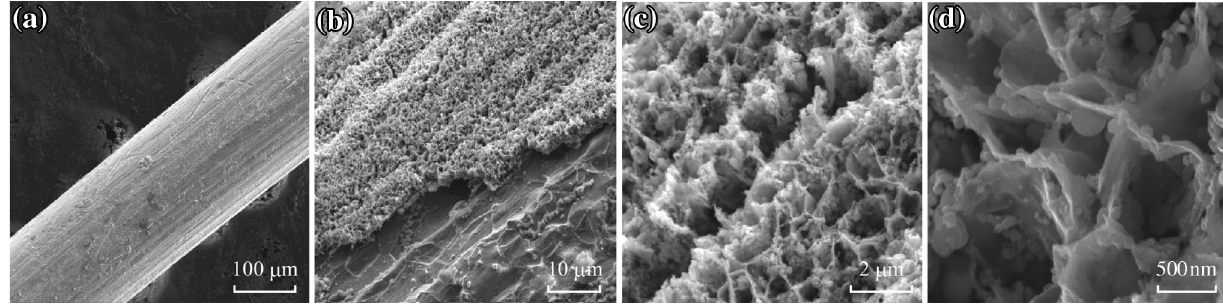
Fig. 1 SEM images of Fe@Fe 3 O 4 at different magnifications